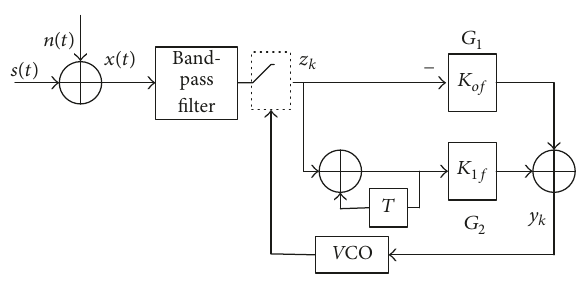
Figure 5: Kalman filter structure block